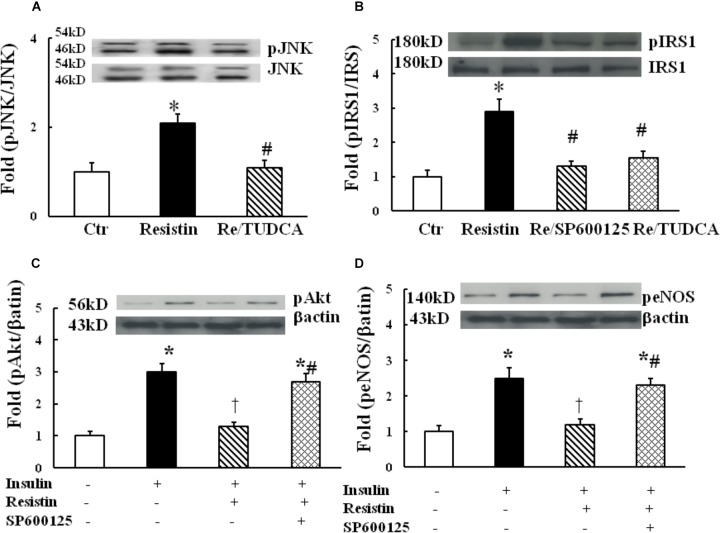
Effect of JNK inhibition on insulin signaling through IRS1/Akt/eNOS pathway in the resistin-treated HUEVCs. (A) Resistin (100 ng/mL) increased JNK phosphorylation, which was prevented by TUDCA (N = 7, per condition); (B) TUDCA (500 μg/mL) or JNK inhibitor (12.5 μmol/L) prevented resistin-induced IRS phosphorylation at serine residue (Ser 307); (C,D) JNK inhibitor Sp600125 (12.5 μmol/L) improved insulin signaling molecules pAkt (Ser 473), peNOS (Ser1177) impaired by resistin (N = 7, per condition). ∗p < 0.05, vs. control, #p < 0.05, vs. correspondence resistin group, †p < 0.05 vs. insulin group.